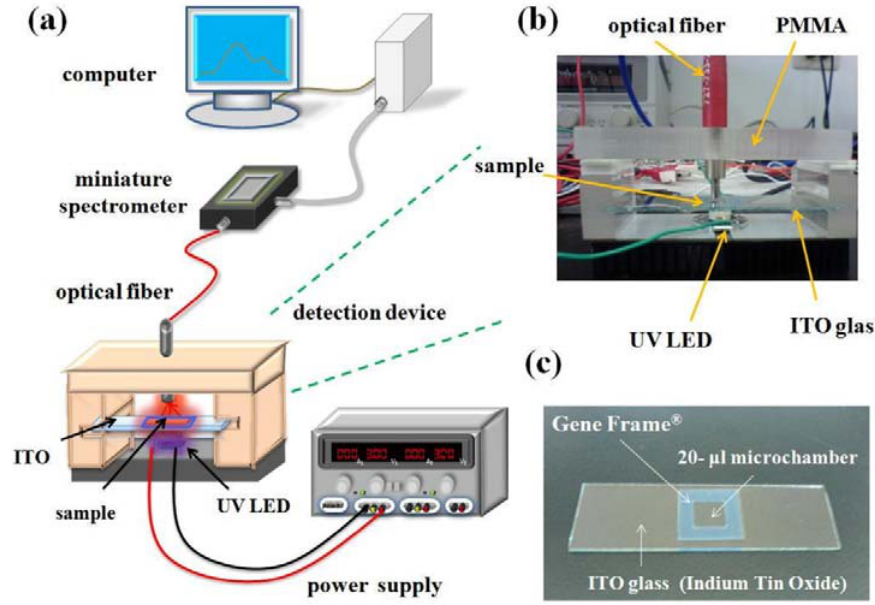
Figure 1. The homemade FRET detection system based on a single 400 nm UV LED, a disposable ITO glass slide, a miniature 16-bit CCD-array spectrophotometer, and